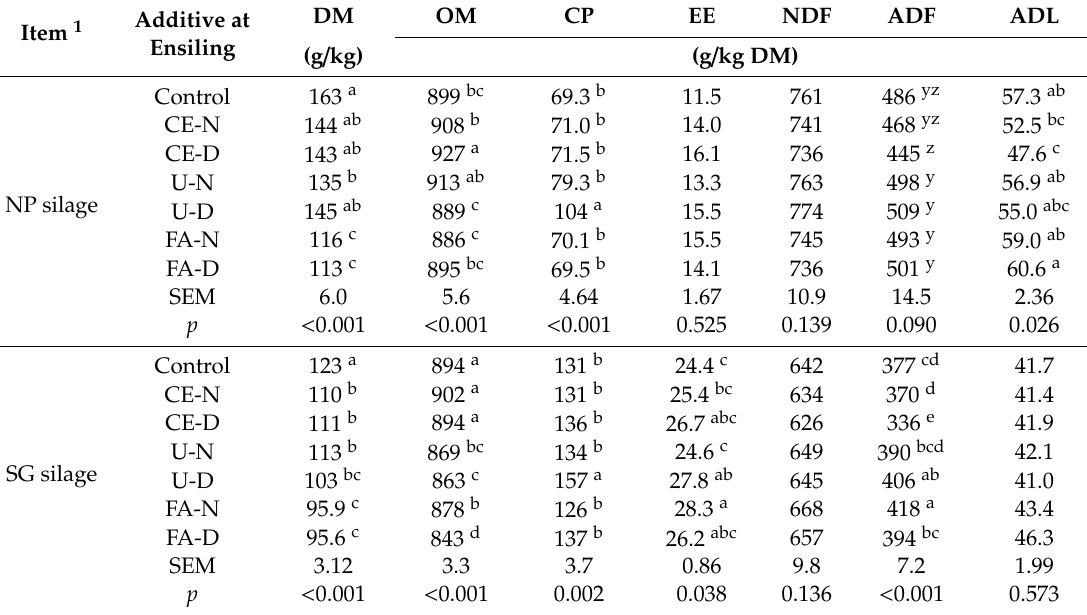
Table 4. Chemical composition of silages after 30 d of